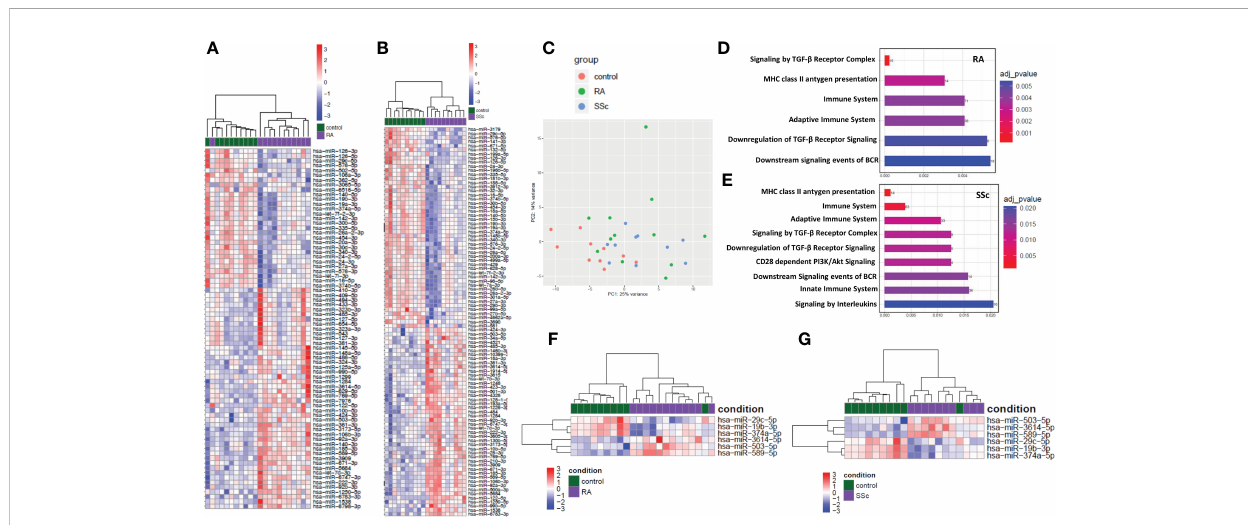
FIGURE 1 Global analysis and distribution of miRNA-seq in RA and SSc monocytes. Heatmap of signi fi cantly dysregulated miRNA in RA (A) and SSc (B) monocytes compared to HC. Principal component analysis (PCA) plot of global miRNA distribution in RA (green), SSc (blue) and HC (red) monocytes (C) . Enrichment analysis of abundantly expressed miRNA regulating selected genes involved in immune pathways in RA (D) and SSc monocytes (E) . Heatmap analysis of selected miRNA in RA (F) and SSc (G) monocytes compared to